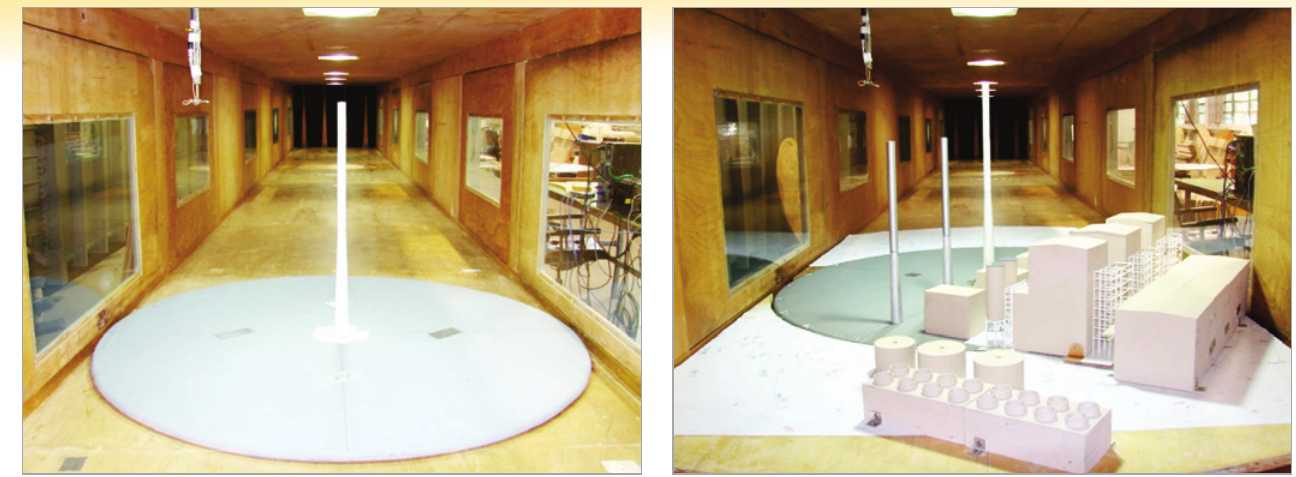
Photograph of the chimney aeroelastic model inside the wind tunnel. Configuration I: isolated chimney.